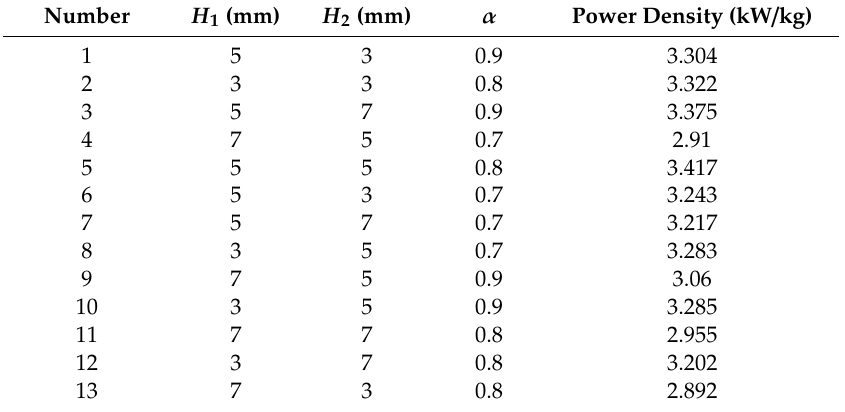
Table 2. Table of experimental